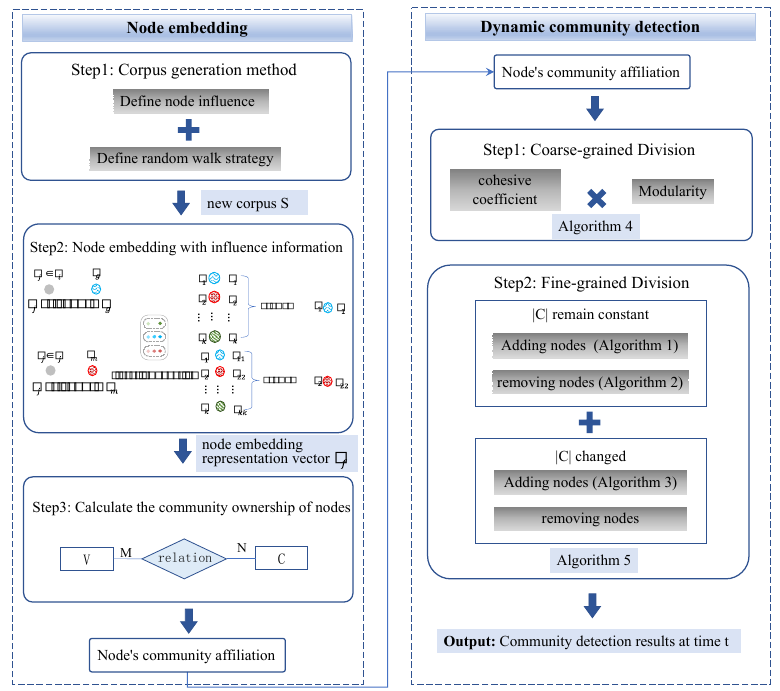
Figure 1. Model frame of proposed algorithm.